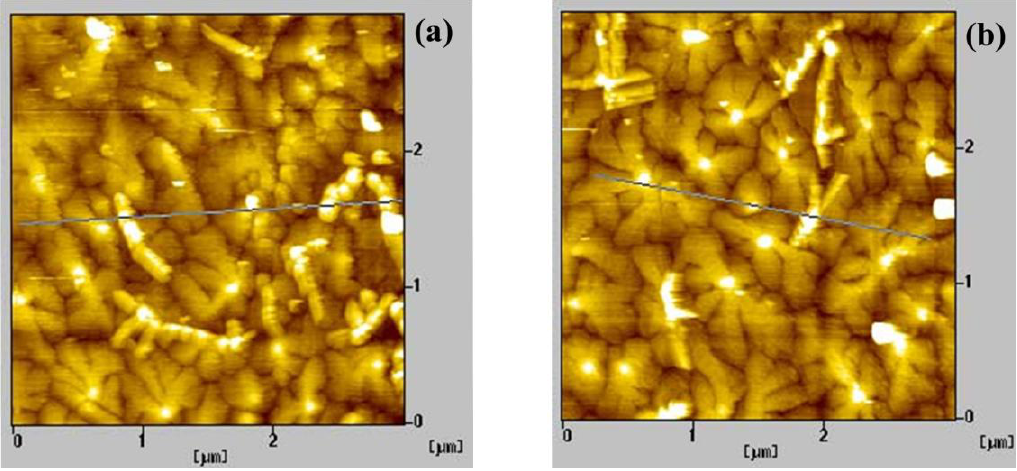
Figure 2. AFM images (3  m  3  m) of the pentacene films grown on (a) the PVP and (b) PS